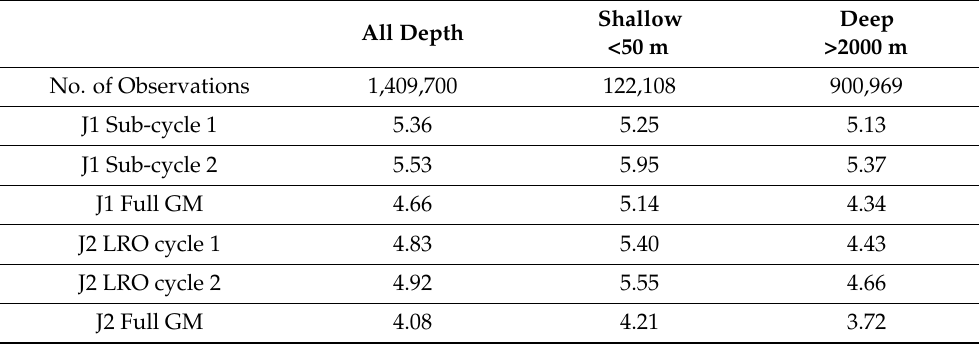
Table 3. Comparison with marine gravity data shown in Figure 2. The STD of the differences in mGal are shown for all depth and for shallow water (less than 50 m) and for deep water (greater than 2000